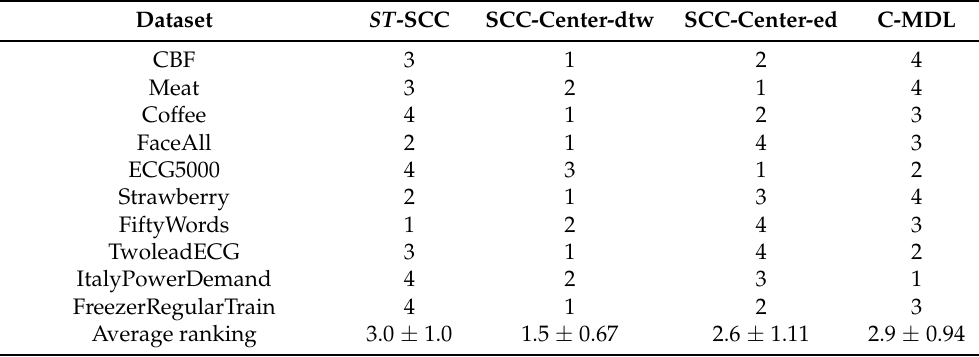
Table 3. Ranking of different methods for the labelling performance for U set.